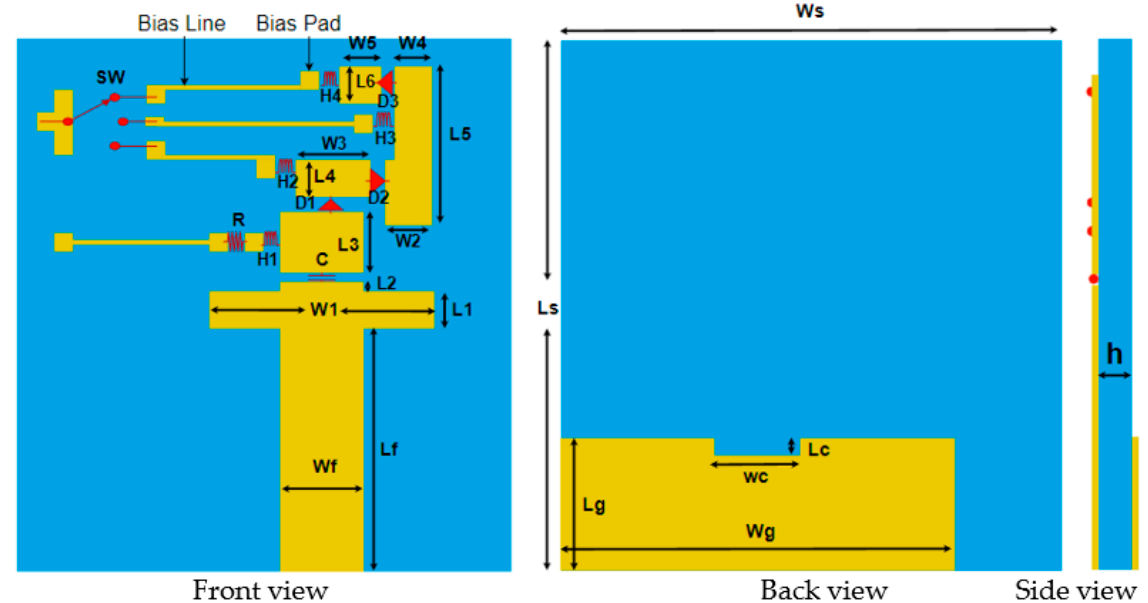
Figure 1. The suggested antenna geometry.